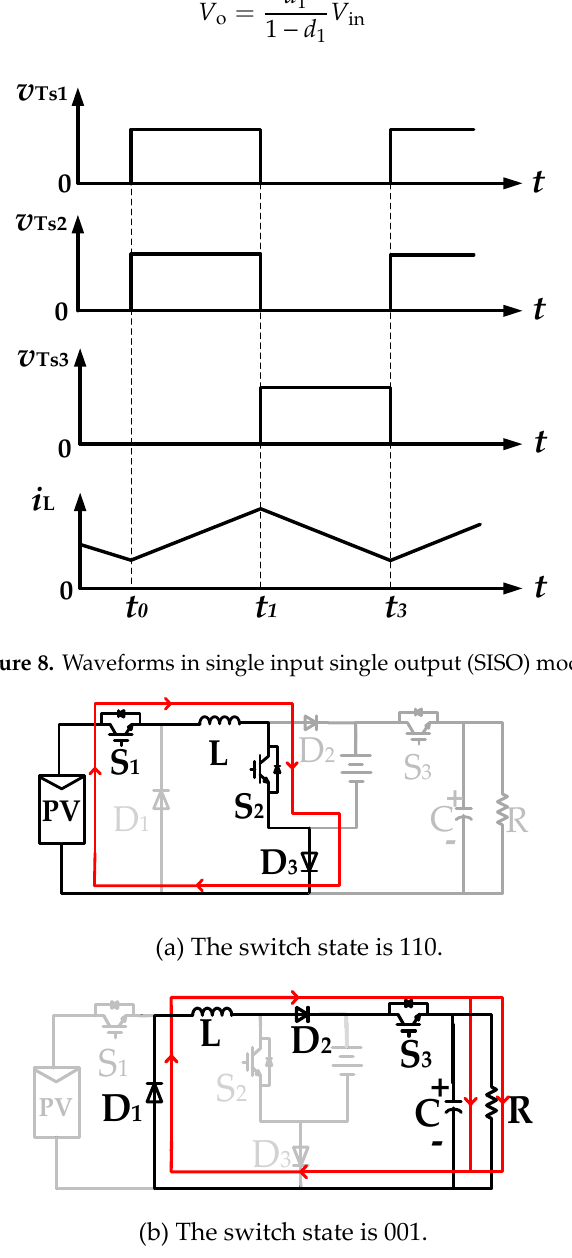
Figure 9. Working states of SISO mode.